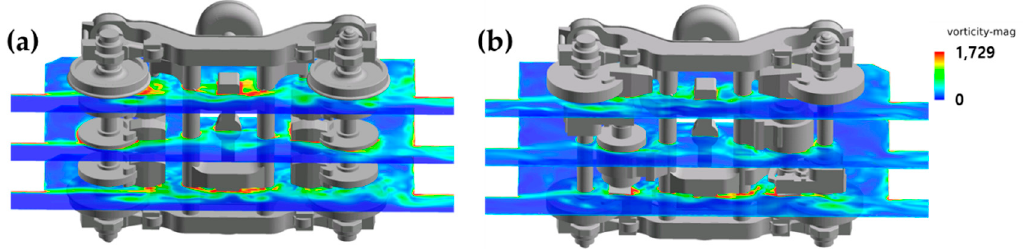
Figure 9. Instantaneous vorticity magnitude contours in x–z plane at y= − 0.6m, 0, 0.6m: ( a ) first bogie; ( b ) eighth bogie.